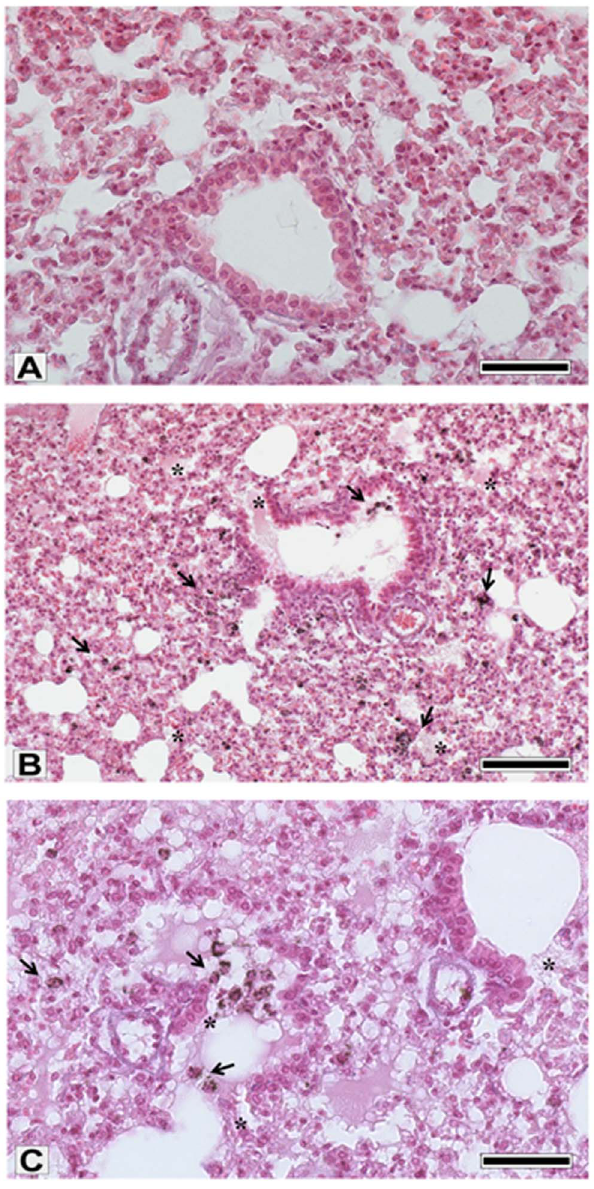
Figure 3. Lung histological analyses. (A): sham lung parenchyma. (B, C): PM2.5win exposed lung parenchyma showing the abundant particulate matter engulfed in phagocytic cells along the lung parenchyma end in cells free in the bronchiolar lumen (arrows), as well as the tissue lesions and exudates (asterisks). A, C, bars =50 m m; B, bar =150 m m.